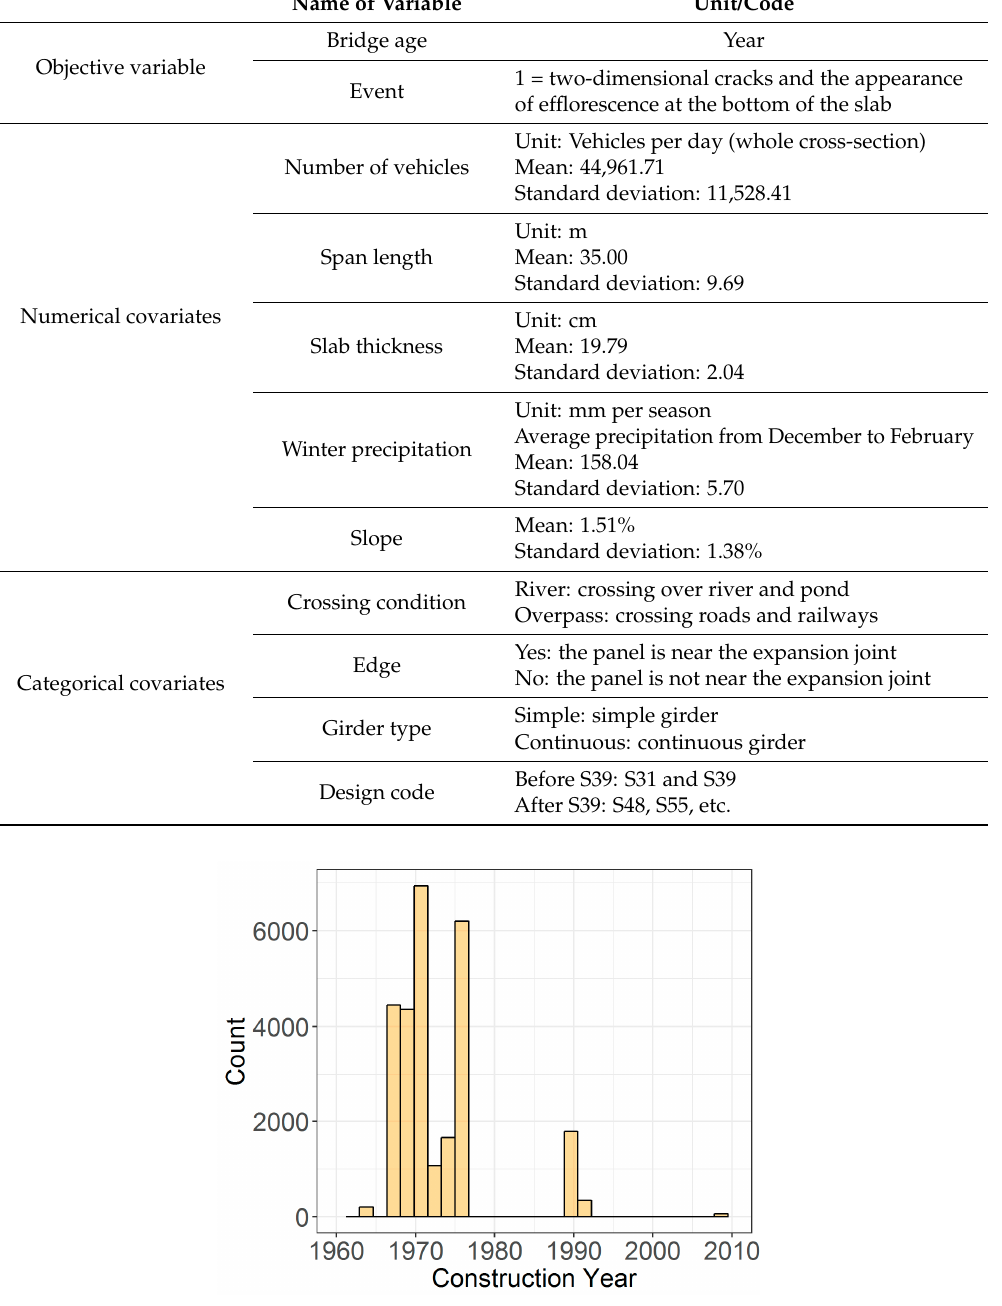
Figure 14. Construction year of panels in the Tokyo region.